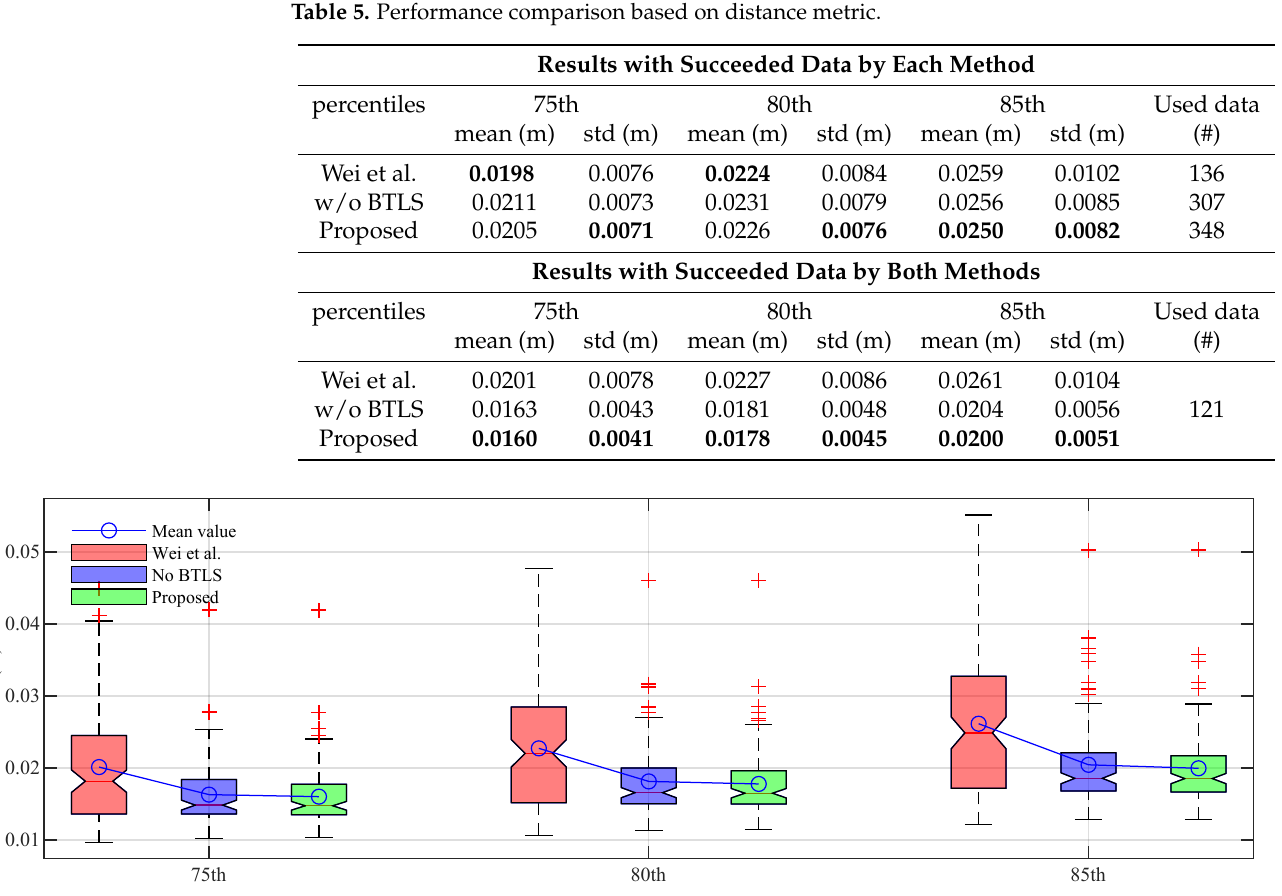
Figure 10. Boxplots of results with succeeded data using triple methods summarized in Table 5. The method of Wei et al. [10], the proposed method without Backtracking Line Search step, and the proposed method are colored in red, blue, and green, respectively. Mean distances of triple methods are denoted as blue lines and circle markers, respectively, to visualize the results of Table